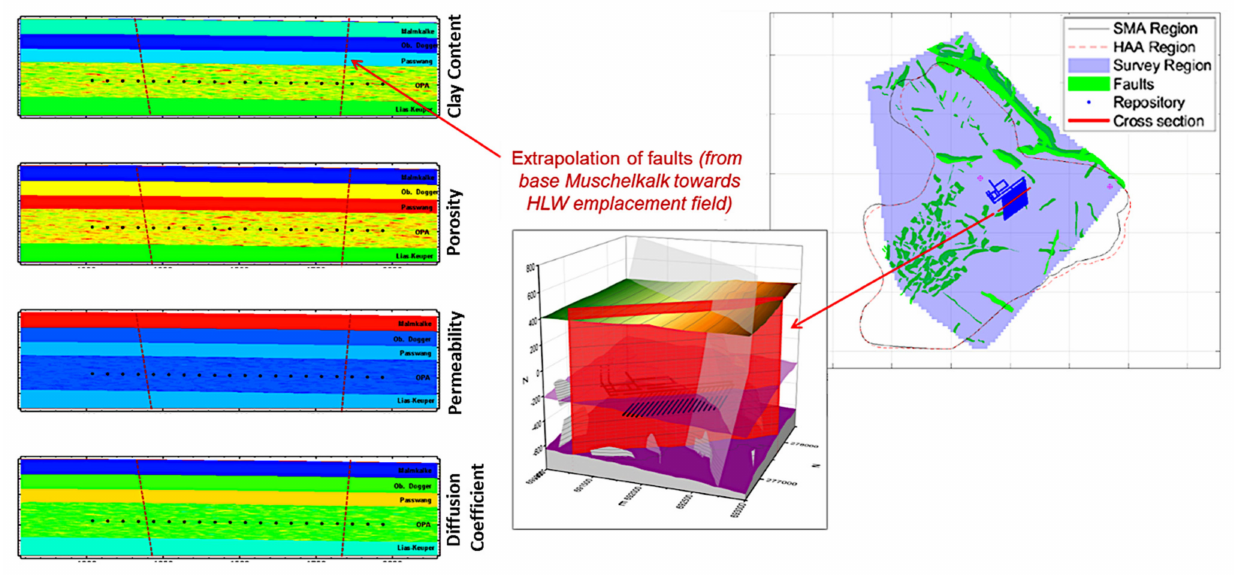
Figure 6. Substruction of a 2D assessment model from a 3D repository model. Heterogeneous property distributions (top–down: clay content, porosity, hydraulic conductivity, effective diffusion coefficient) assigned to the host rock and implementation of discrete seismic faults through the stack of geological formations.